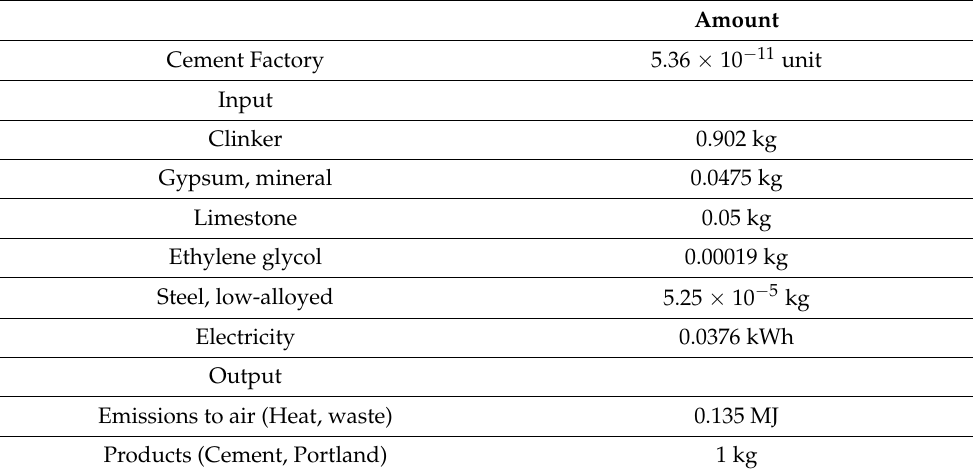
Table 1. List of input/output data of Portland production